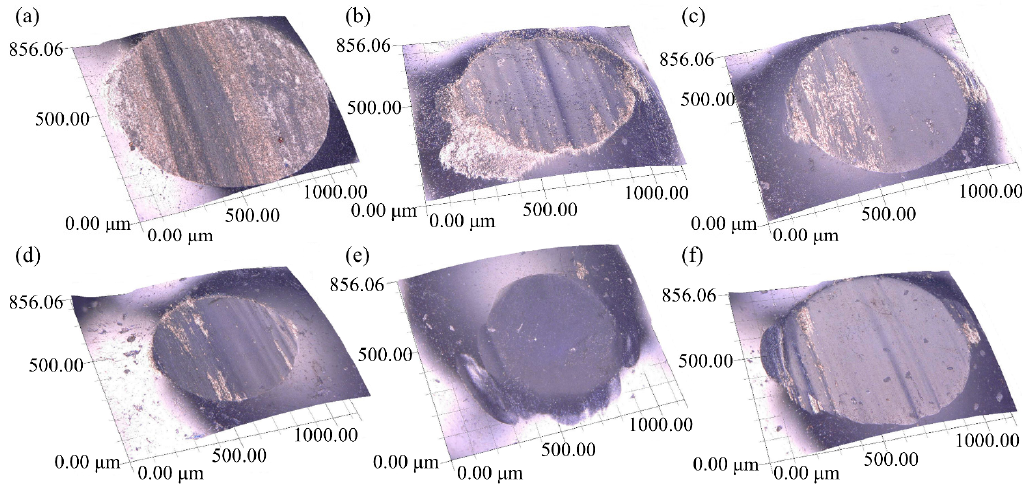
Figure 9. The worn surfaces of the corresponding counterbody balls of: ( a ) TiAl4V; ( b ) 0Ce; ( c ) 1Ce; ( d ) 3Ce; ( e ) 5Ce; ( f ) 7Ce coatings.